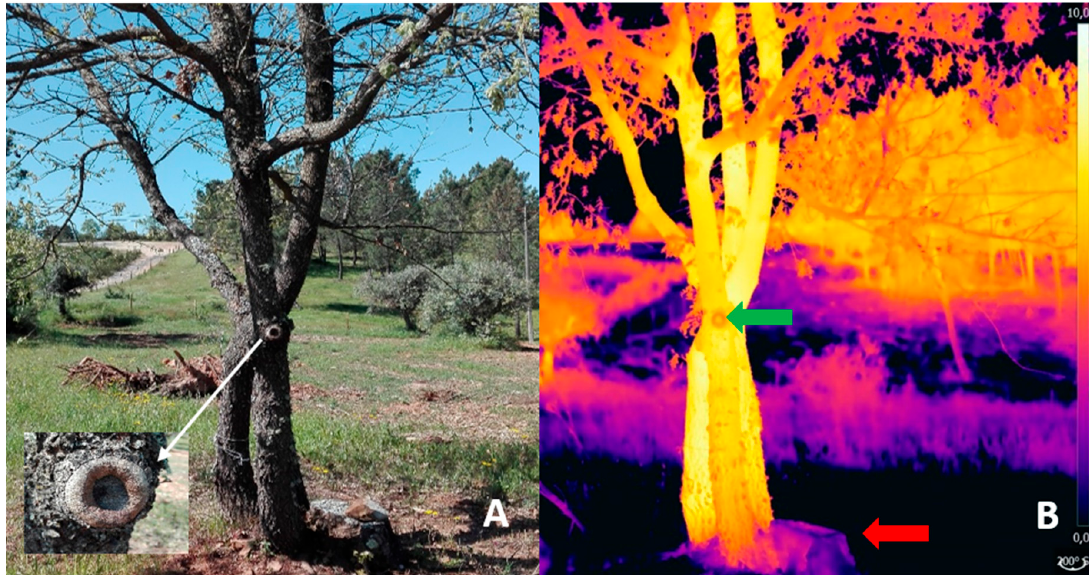
Figure 8. Photo ( A ) and thermogram ( B ) of the Quercus pyrenaica Willd tree. The white arrow shows an enlarged image of the CODIT development wall; the green arrow shows the same wall of CODIT on the thermogram; the red arrow indicates a stump. CODIT: compartmentalization of decay in trees.